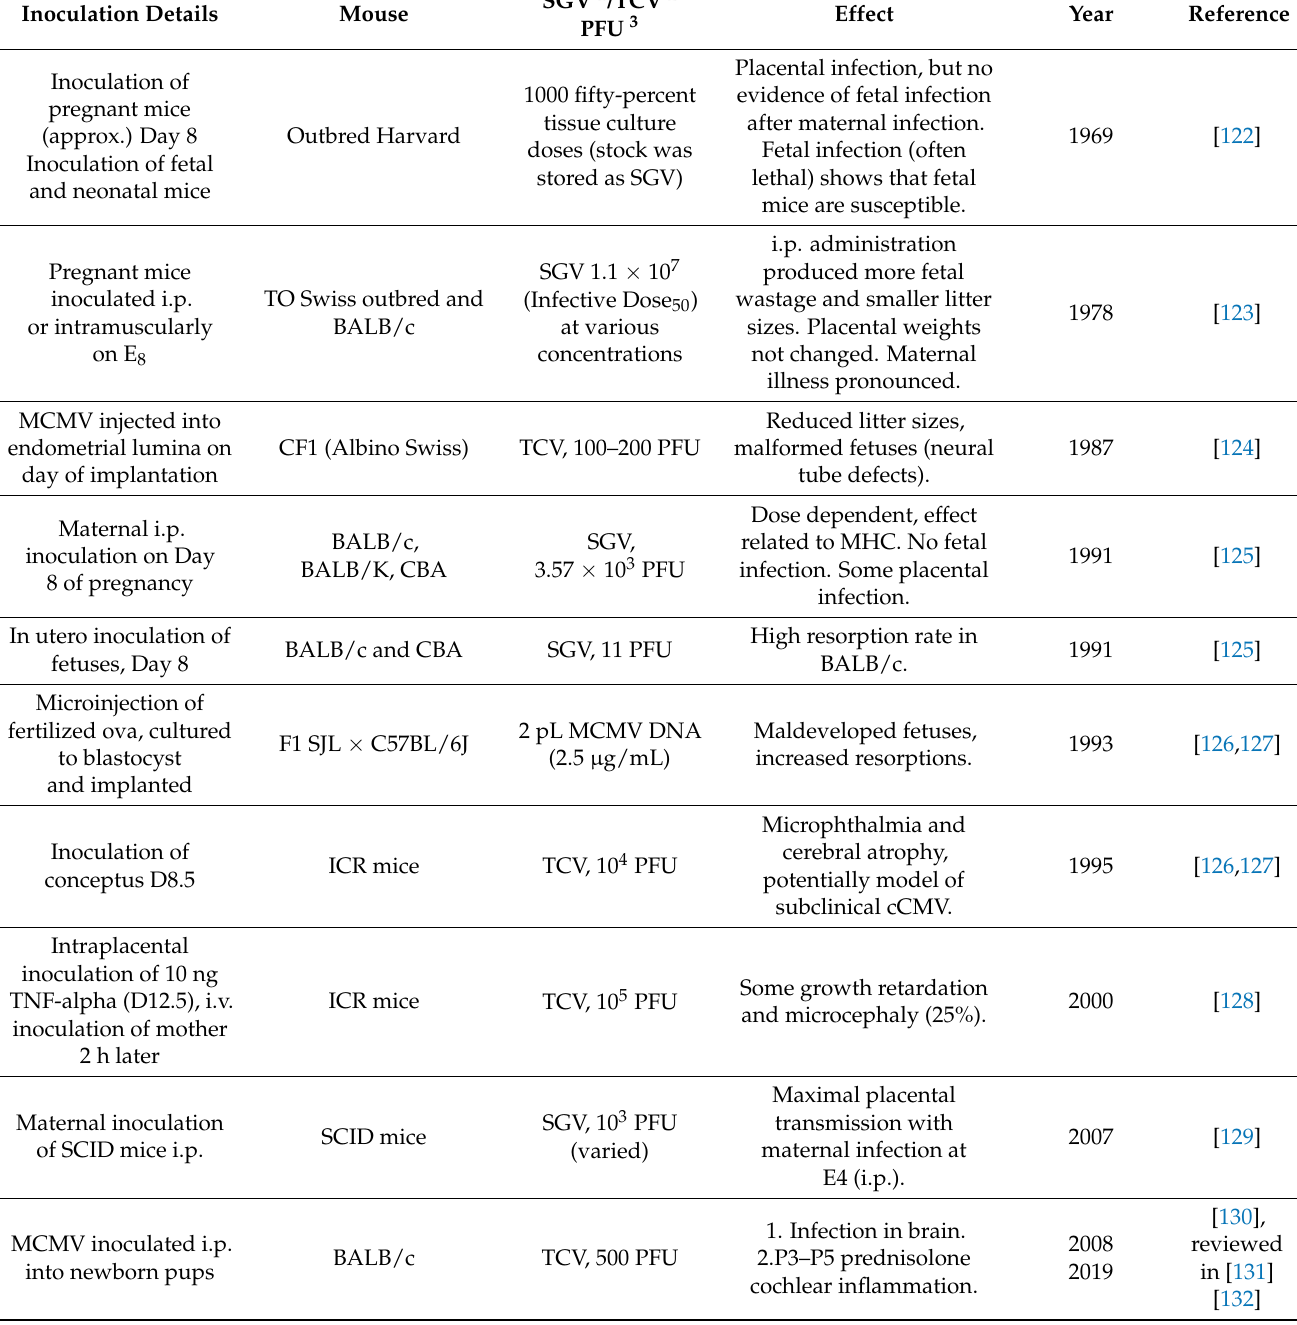
made to model congenital disease, mostly with frustrating outcomes [120]. Experimental manipulation of the mouse/MCMV model to simulate human cCMV disease is shown in Table 4. To date, the most successful model of congenital disease is the guinea pig model (discussed in [121]). However, the disease is generally acute, and there are limitations with reagent availability and the lack of inbred lines for experimentation. Guinea pigs also have a much longer gestation period (around 65 days, compared with 21 days for mice) and often have three or fewer pups. Table 4. Mouse models of human congenital cytomegalovirus (cCMV) disease (chronological